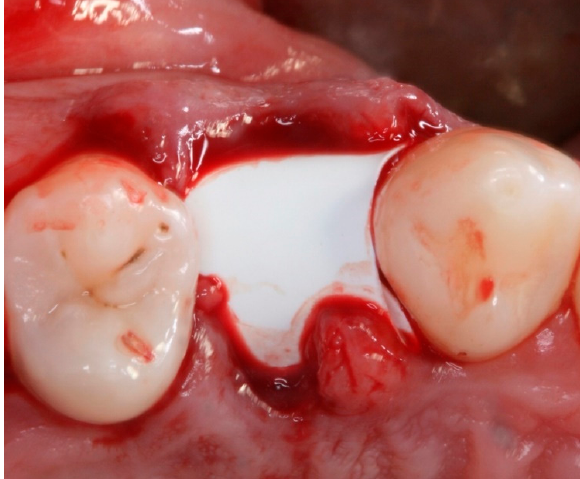
Figure 4. Intraoral occlusal view of the position of the a dense polytetrafluoroethylene (dPTFE) membrane (TG1).